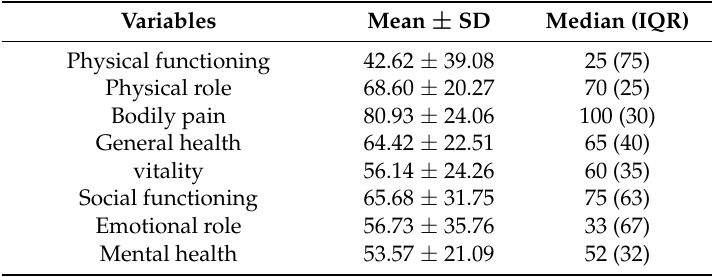
Table 3. Mean ± SD, median, and IQR of SF-36 scores.